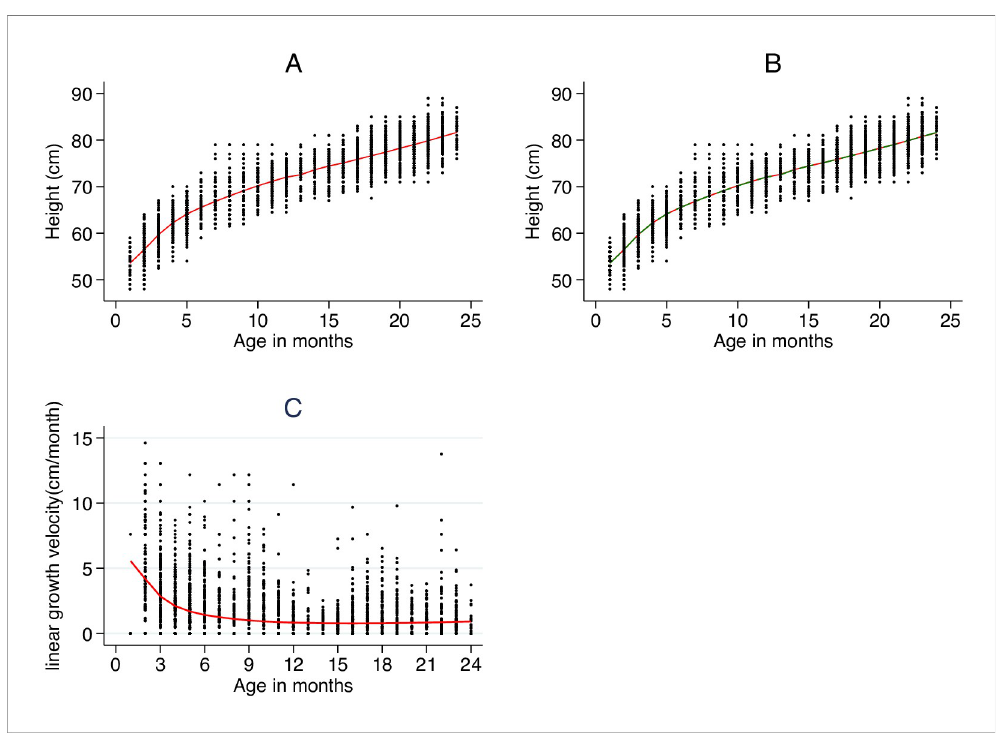
Fig 2. Observed and predicted linear growth mixed-effects model. Legend: in red and blue are average predicted growth curves for infants who are HUU and those who are HEU, respectively. Observed and predicted linear growth curves for all children ( a ); Observed and predicted mean linear growth for infants HUU and HEU ( b ). Observed and predicted linear growth velocity for infants who are HUU and HEU ( c ).